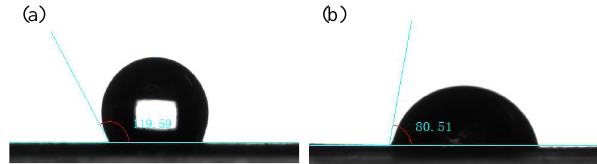
Figure 4. Contact angles: ( a ) CP; ( b )